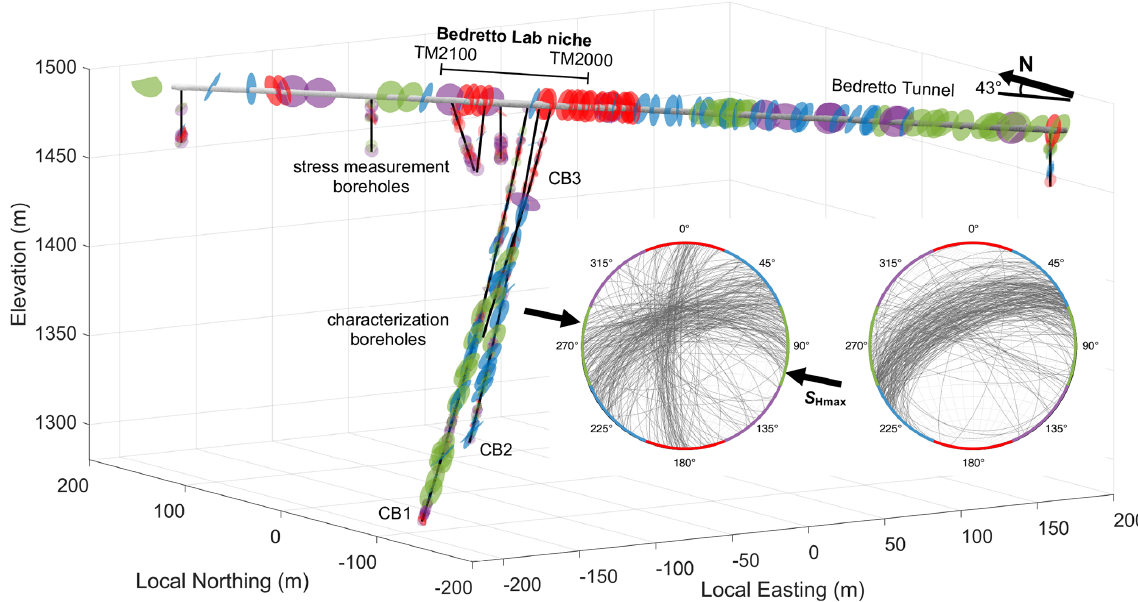
Figure 2. Configuration of the CB1, 2 and 3 boreholes with respect to the Bedretto Tunnel. Fractures and fault zones, mapped along the tunnel and the boreholes, are colored with respect to their strikes. Stress measurement boreholes (SB) are also shown. Inset: stereonet of fractures and fault zones mapped along the tunnel (left) and the CB1, 2 and 3 boreholes (right) (only structures represented in the lower row of Fig. 7), respectively. The four fracture and fault sets are colored distinctly according to their strikes, which is also marked on the circumference of the stereonets. Table 1. List of characterization boreholes and measurements conducted therein. Borehole Location Diameter Length Inclination Logging performed Additional no. (TM) (mm) (m) ( ◦ ) tests CB1 2050 97 303 45 ATV, OTV, GPR, CAL, Cond., DEV, FWS, SGAM, Temp. Mini-frac CB2 2043 97 220 40 ATV, OTV, GPR, CAL, Cond., SGAM, Temp. Pressure monitoring CB3 2037 97 192 50 ATV, OTV, GPR, CAL, Cond., SGAM,